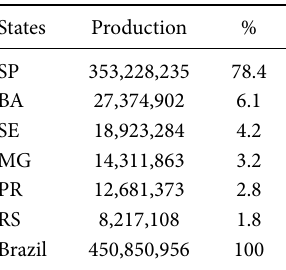
Table 1. Brazilian citrus production –